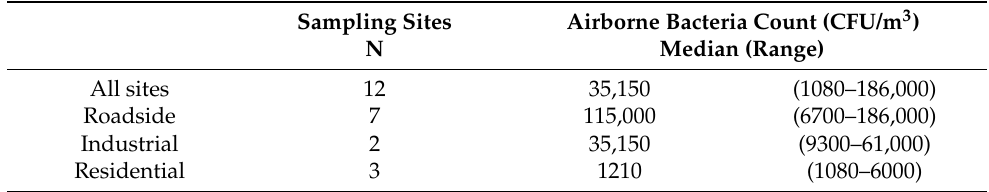
Table 2. Airborne bacteria count for the three types of site (roadside, industrial, residential) from which ambient air was sampled in urban Accra, Ghana (February